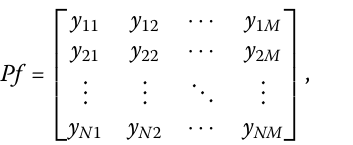
In terms of the G-ABL framework, the process of the collaborative decision-making method can be depicted in Fig. 3. EWM based WK-means is proposed as a